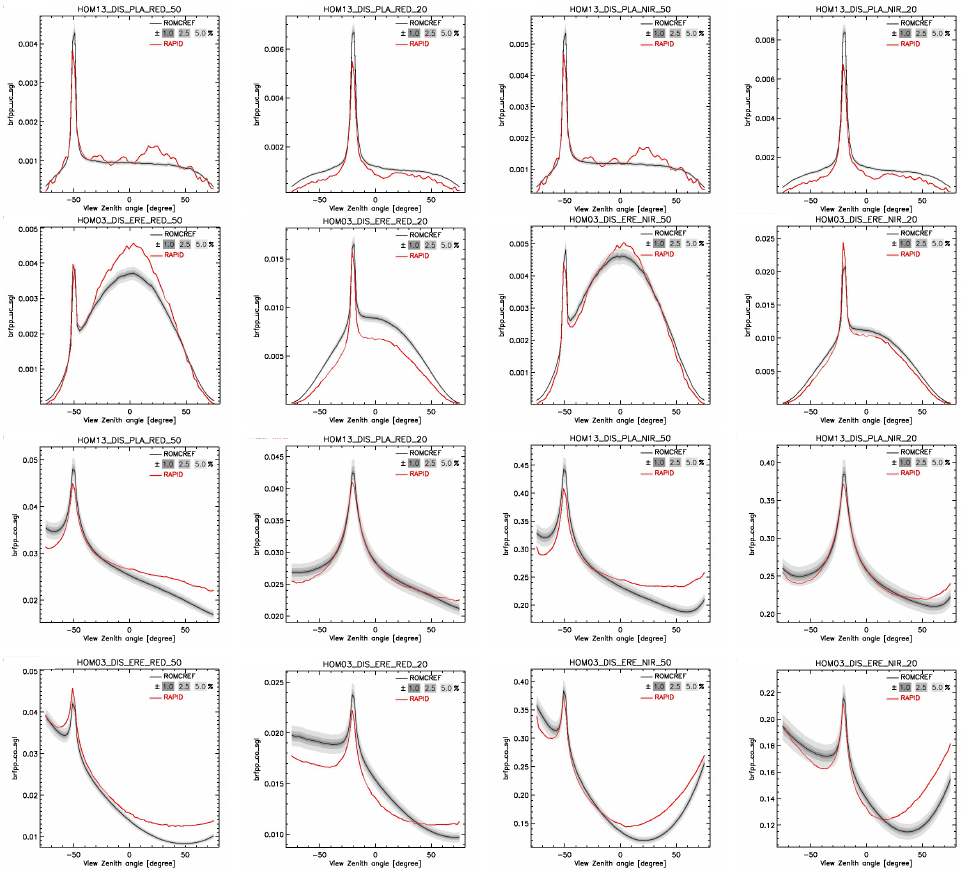
Figure 9. Comparisons of HOM13 and HOM03 single scattering BRF results in the principal plane with the reference data from the RAMI online checker (ROMCREF). In the subtitles, 20 and 50 are the solar zenith angles; the first two rows are brfpp_uc_sgl for soil components, and the last two rows are brfpp_co_sgl for leaf components.